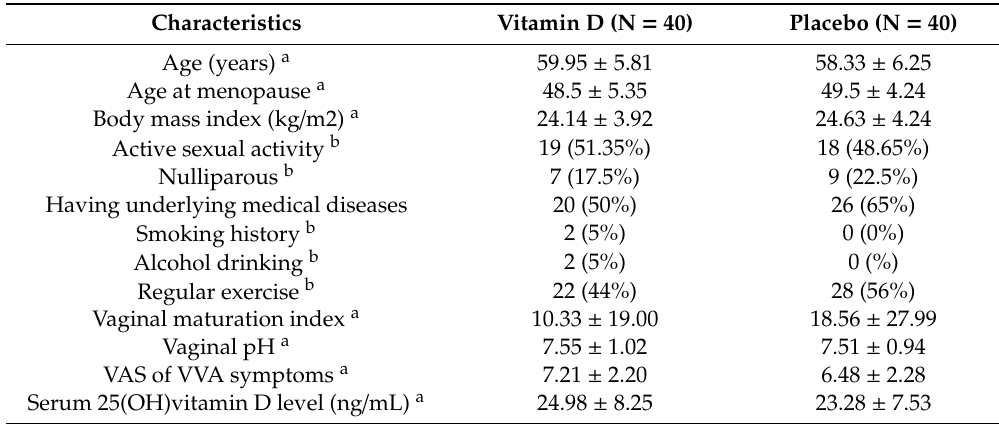
Table 1. Baseline characteristics of the participants.